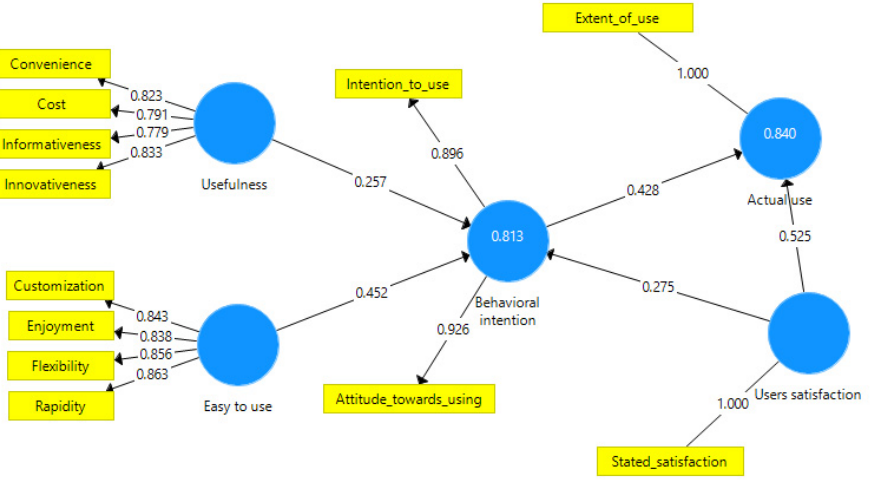
Figure 3. Empirical model. Source: author’s construction using SmartPLS v3.0 (SmartPLS GmbH, Oststeinbek, Germany).